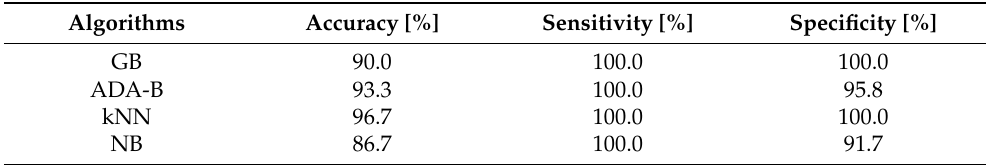
Table 6. Evaluation metrics, using the normal class as reference, per each algorithm after performing a feature selection